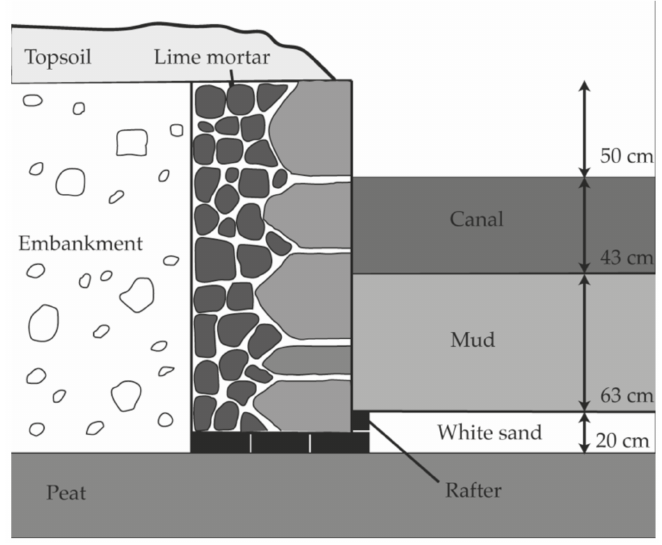
Figure 8. Structural scheme of GC walls, reproduced after [36].